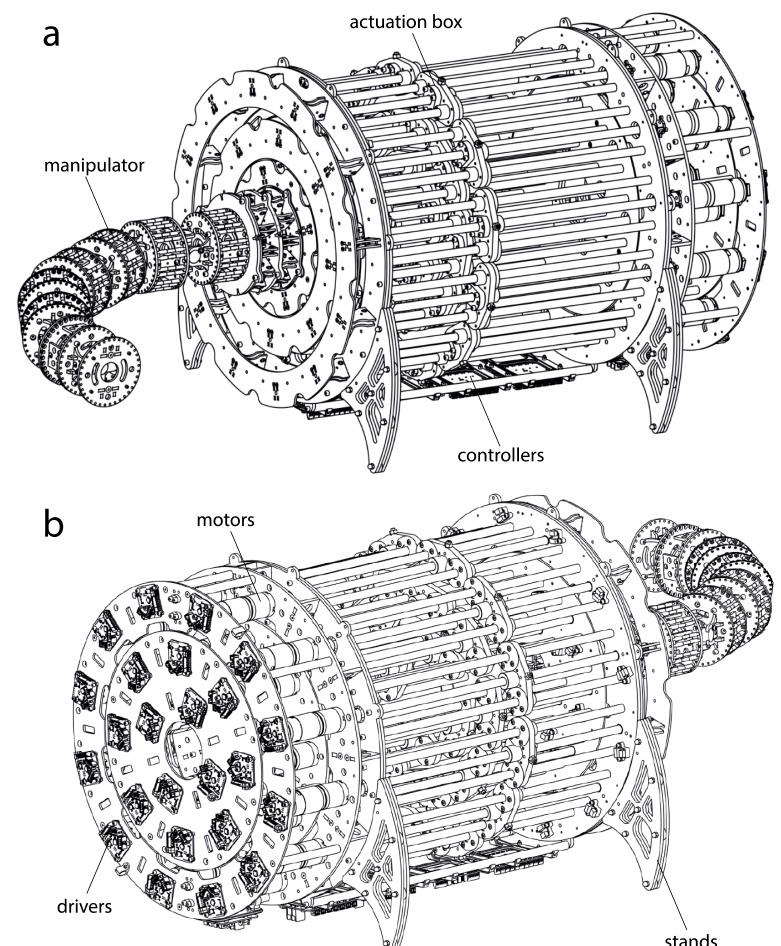
Figure 5. Perspective ( a ) front and ( b ) back view of the complete design of the hyper-redundant robot.